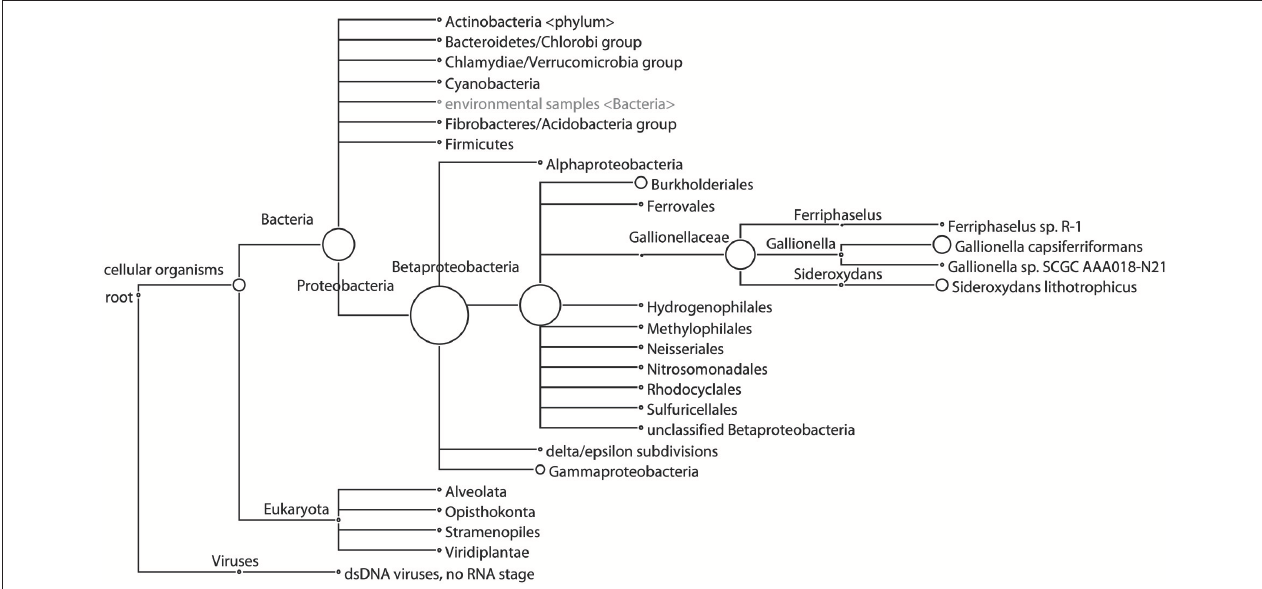
FIGURE 4 | Phylogenetic tree of taxa at Site B predicted from shotgun sequencing analysis. Circle size represents the number of reads assigned to each taxon, showing predominance of sequences classified as multiple genera in the Gallionellaceae family. Taxa only shown when at least 0.1% of reads are assigned.